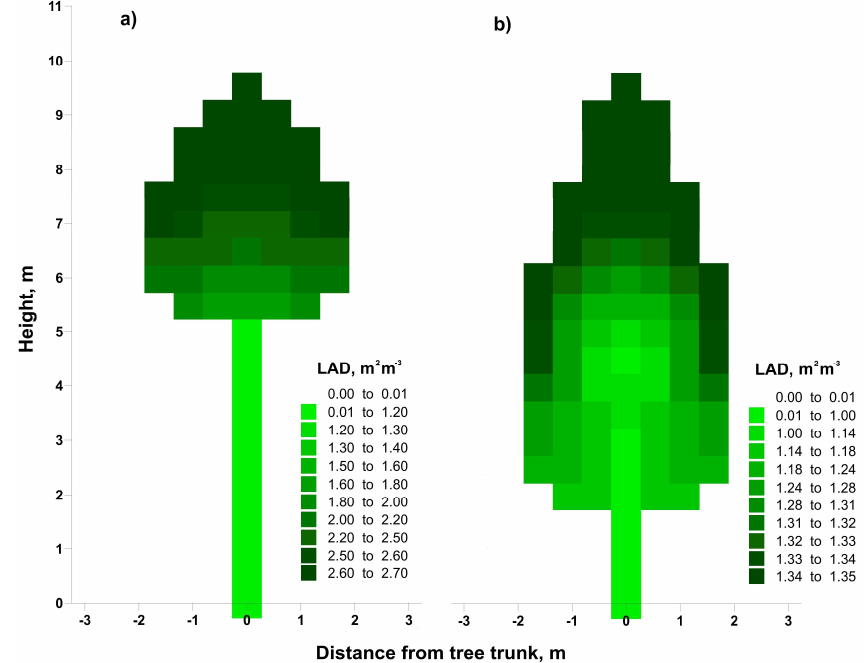
Figure 3. A schematic representation of the spatial distribution of photosynthesizing and non-photosynthesizing phytomass for ( a ) Silver birch and ( b ) Scots pine. Leaf area density (LAD) for Silver birch varied between 0.65 and 2.7 m 2 m −2 and for Scots pine between 0.65 and 1.4 m 2 m −2 .